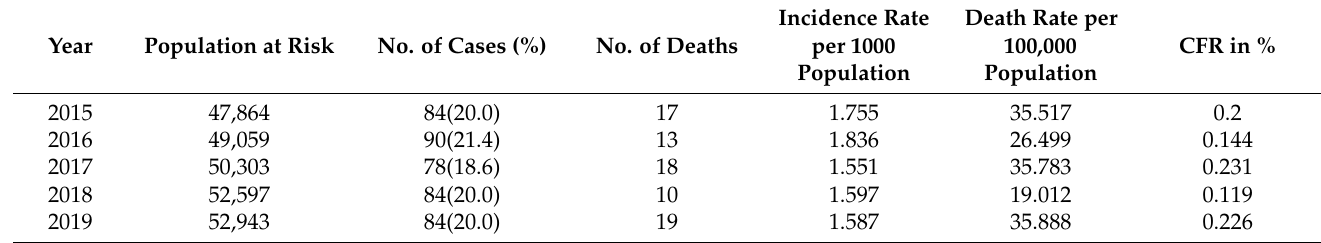
Table 1. Malaria Incidence and Death Rate from 2015 to 2019 Nsanje District.